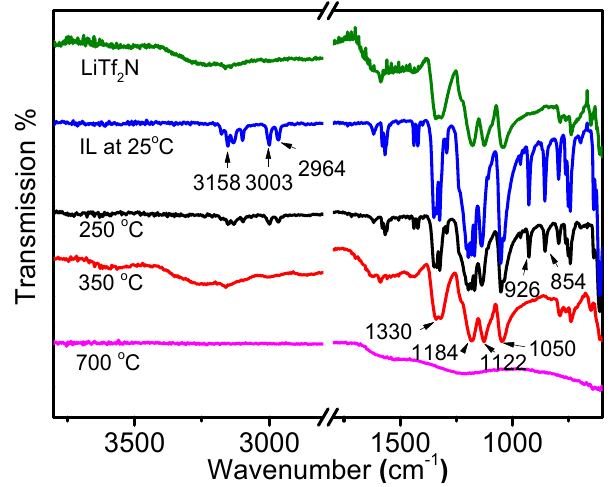
Figure 2. FTIR spectra of carbonization products of IL prepared after 5 min at temperatures from 25 to 700 °C.